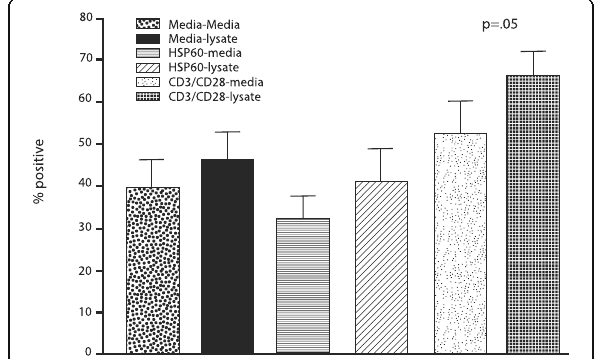
Fig. 2 Expression of CTLA-4 by CD4+CD25+ cells from six ra patients. Results are shown as mean and standard deviation. CTLA-4 increased slightly despite the decrease in CD69 expression (not shown) and was significant in the case of the CD4+CD25+ T cells following the addition of primary ultrafiltrate (From Caruso I et al J Transl Med (2016) 14:162)